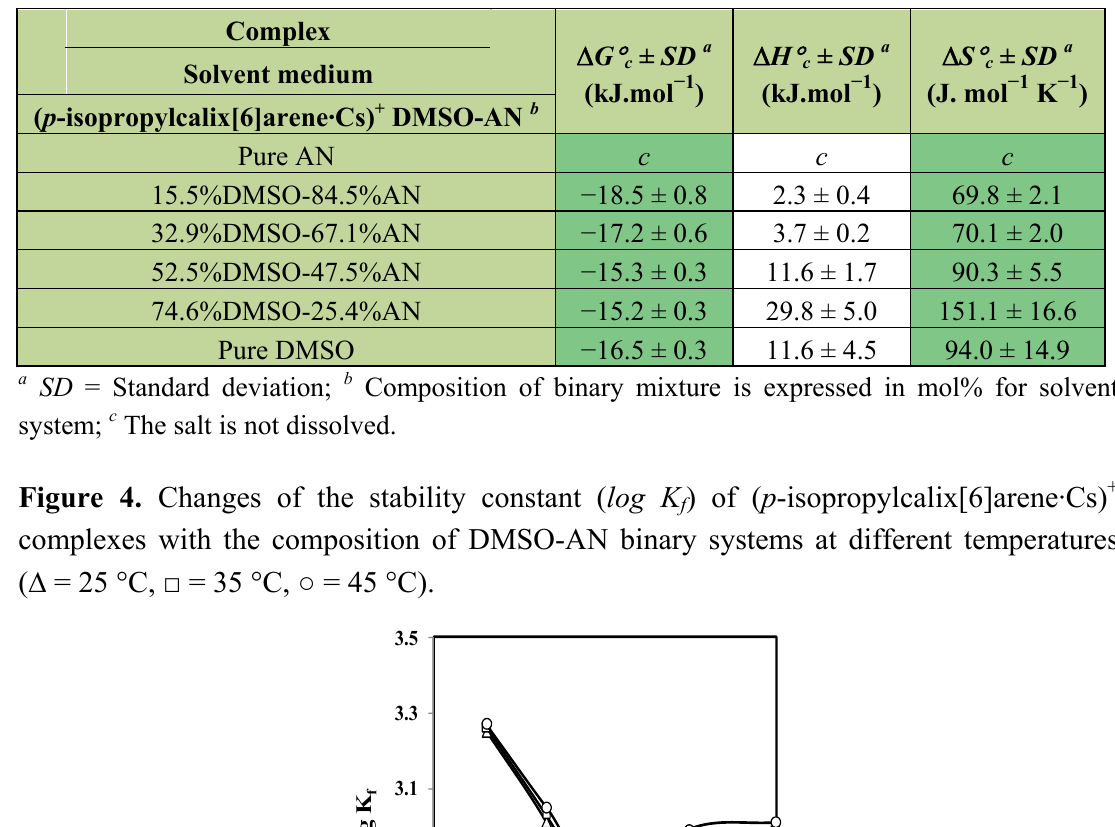
Table 3. Thermodynamic parameters for ( p -isopropylcalix[6]arene·Cs) + complex in DMSO-AN binary mixed solvent.